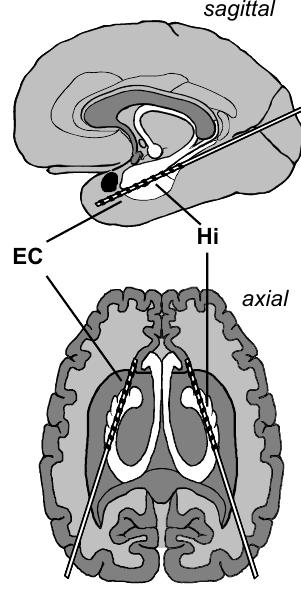
Figure 1. Electrode implantation scheme. Longitudinal depth electrodes are placed with the anterior contacts located in the entorhinal cortex (EC) and the posterior contacts located in the hippocampus